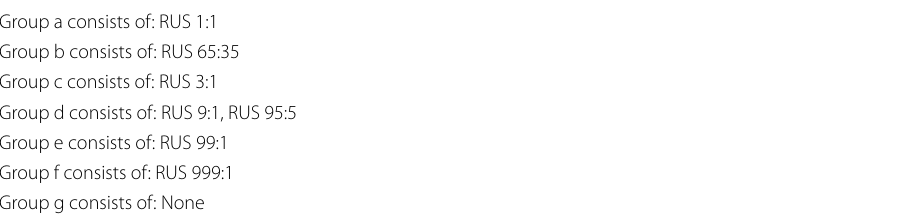
Table 12 HSD groupings of sampling ratios after 2-factor ANOVA where classifier and sampling ratio are factors with Brute Force web attacks; groups are by performance in terms of AUC